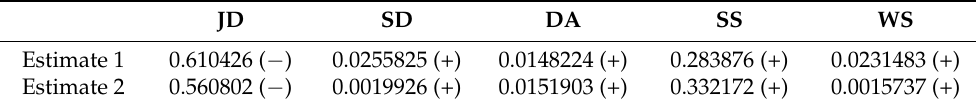
Table 1. Analysis of the first order. Contribution to the variance and sign.